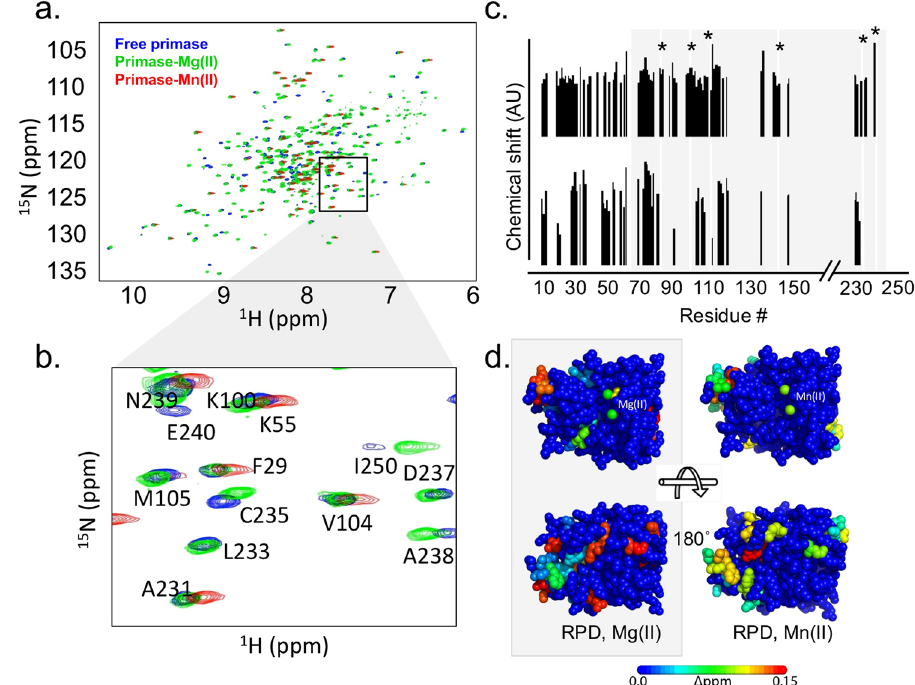
Figure 4. Effect of divalent metal binding on the structure of T7 primase. ( a ) [ 1 H, 15 N]-TROSY HSQC titration spectra of 15 N-deuterated T7 DNA primase without or in the presence of 10 mM Mg(II) or 1 mM Mn(II). NMR experiments for backbone assignments were described recently 40 . Presented are HSQC data for free DNA primase (blue) and for primase bound to Mg(II) (green) and to Mn(II) (red). ( b ) Selected peaks are shown with assigned amino acid resonances as indicated. ( c ) Values of chemical shifts are indicated for Mg(II) (top) and Mn-substituted (bottom) T7 primase. ( d ) RNA polymerase domain (RPD) of T7 primase is indicated in grey box. Residues found 15 Å or closer to a metal ion in the crystal structure are marked with an